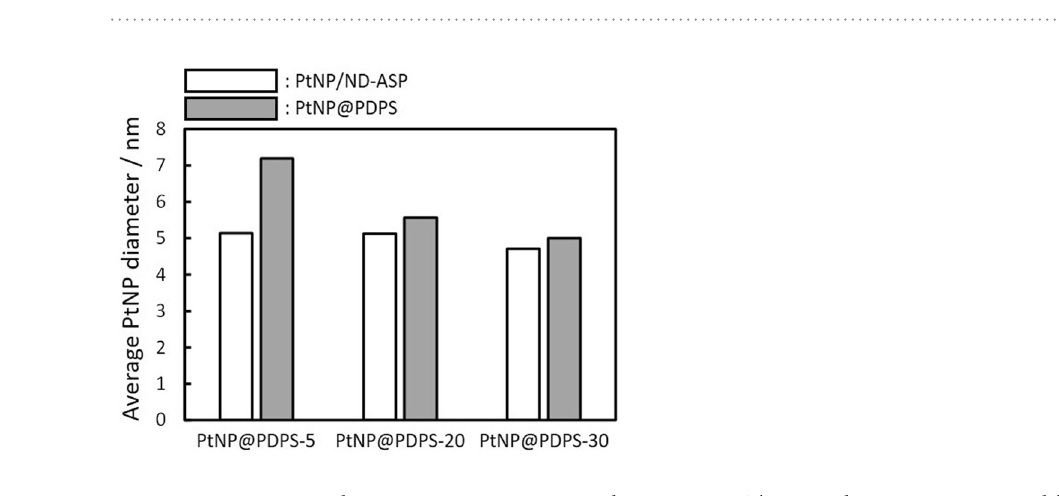
Figure 3. XPS spectra for PtNP@PDSP-5 with PtNP contents of ( a ) 0.1 and ( b ) 1.0 wt%. Pt 4 f spectra for PtNP@PDSP-5 with PtNP contents of ( c ) 0.1 and ( d ) 1.0 wt%.